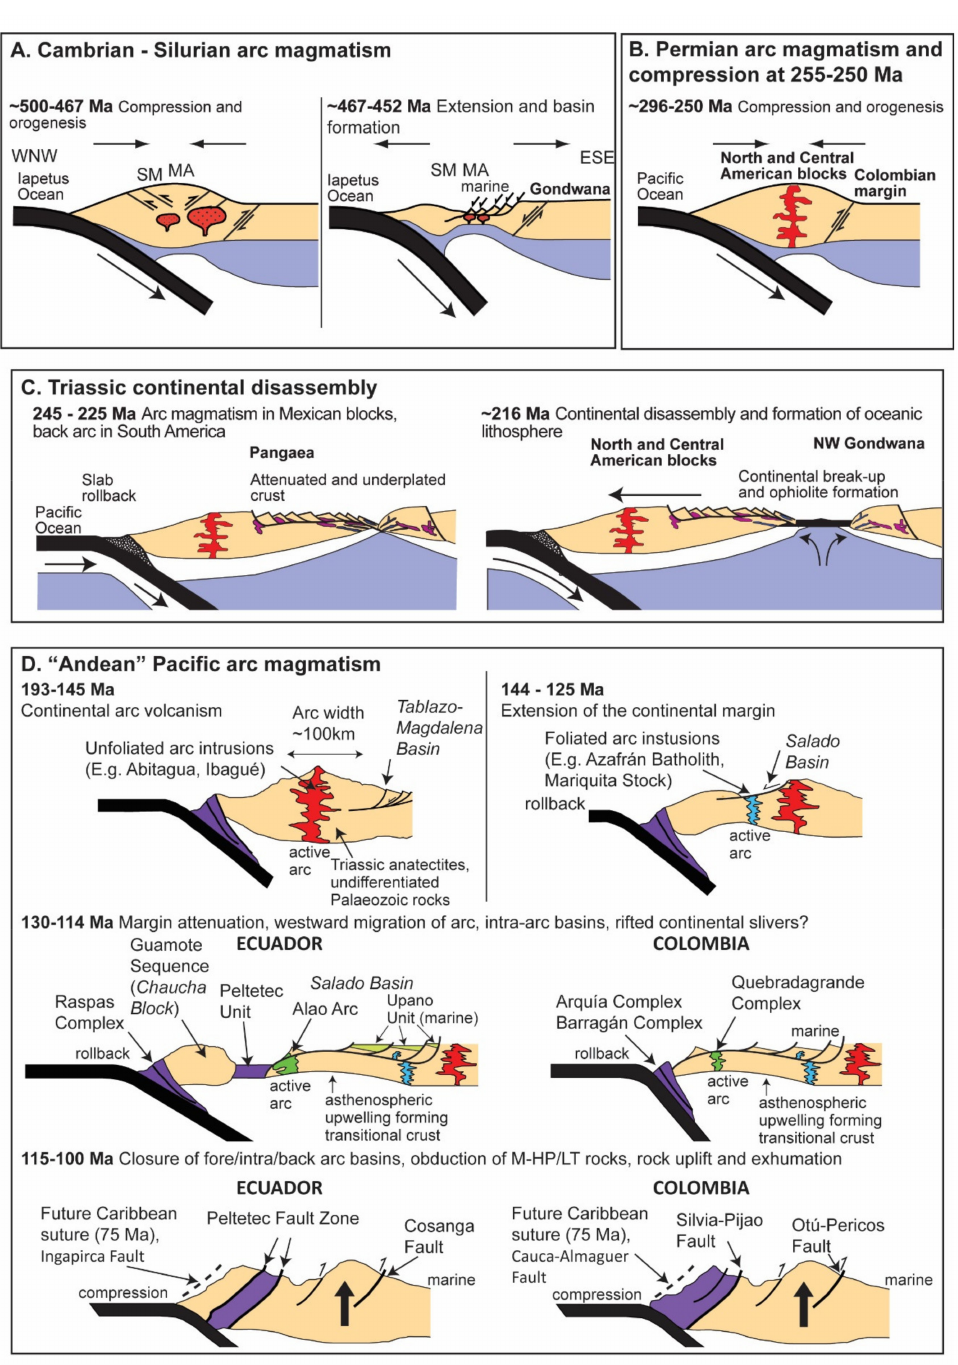
Figure 9. Simplified cross-section models for ( A ) the Cambrian–Earliest Devonian, showing the com- pressive phase during 499–467 Ma (from [2]), ( B ) Permian continental arc magmatism (296–250 Ma) in a compressive, metamorphic setting during ~255–250 Ma, ( C ) a rift-to-drift transition originating in the Triassic back-arc during 245–216 Ma, giving rise to bimodal magmatism and the formation of oceanic lithosphere (from [24]), ( D ) Prolonged continental arc magmatism forming generally unfoli- ated high-K calc-alkaline intrusions in the Merida Andes and Santander Massif during 213–194 Ma, a wide (~100 km) unfoliated calc-alkaline arc in the cordilleras Central and Real during 193–145 Ma, and younger foliated arcs during 144–112 Ma that formed on highly attenuated crust. The amount of extension increased southwards, detaching continental crust and forming transitional crust in Ecuador (from